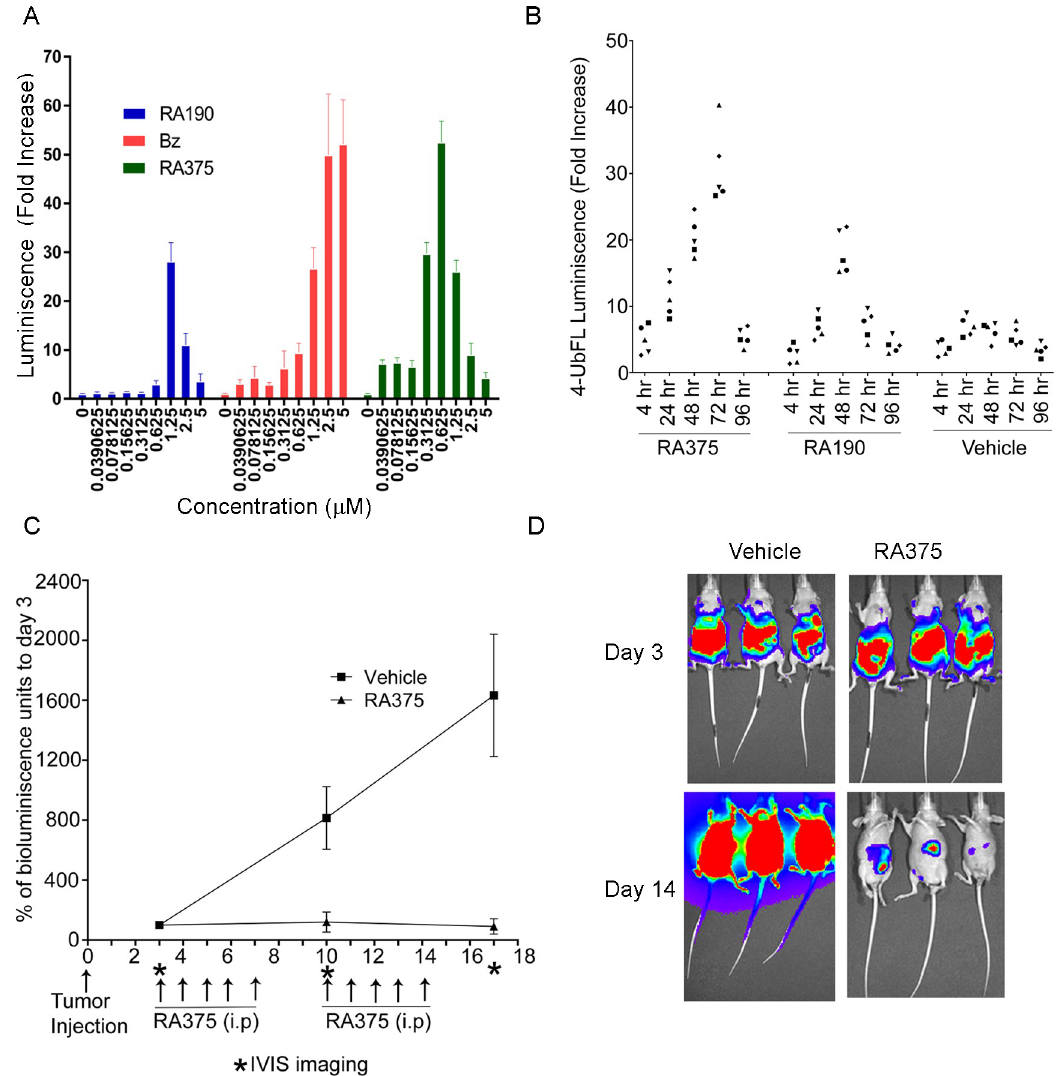
Fig 5. RA375 inhibits proteasome function and reduces ovarian tumor burden in mice. (A) 293T cells in 96 well plates were transiently transected with the 4UbFL plasmid and 48 hr later treated with the indicated doses of each compound for 4 hr. Cells were lysed and luciferase activity assessed using a luminometer. (B) BALB/c mice were electroporated with 4UbFL plasmid (10 μ g/ mouse) in the leg muscle and the basal luminescence was recorded after 48 hr. Groups of mice (n = 5) were treated with different compound (40 mg/Kg) or vehicle alone (25% ( w / v ) β -Hydroxypropylcyclodextrin in water). Mice were imaged for bioluminiscence activity using IVIS instrument at 4, 24, 48, 72 and 96 hr. (C-D) Nude mice (8 per group) were inoculated with 10 6 ES2-luc cells i . p . in 100 μ L PBS. Three days later the mice were imaged for basal level (day 0) bioluminescence expression using an IVIS200. Mice were randomized into two groups (n = 8) and treated daily i.p. with RA375 (10 mg/Kg) or vehicle (25% ( w / v ) β - Hydroxypropylcyclodextrin) for a 5 days on, 2 days off cycle for two weeks and imaged again on day 7 and day 14 for tumor burden.